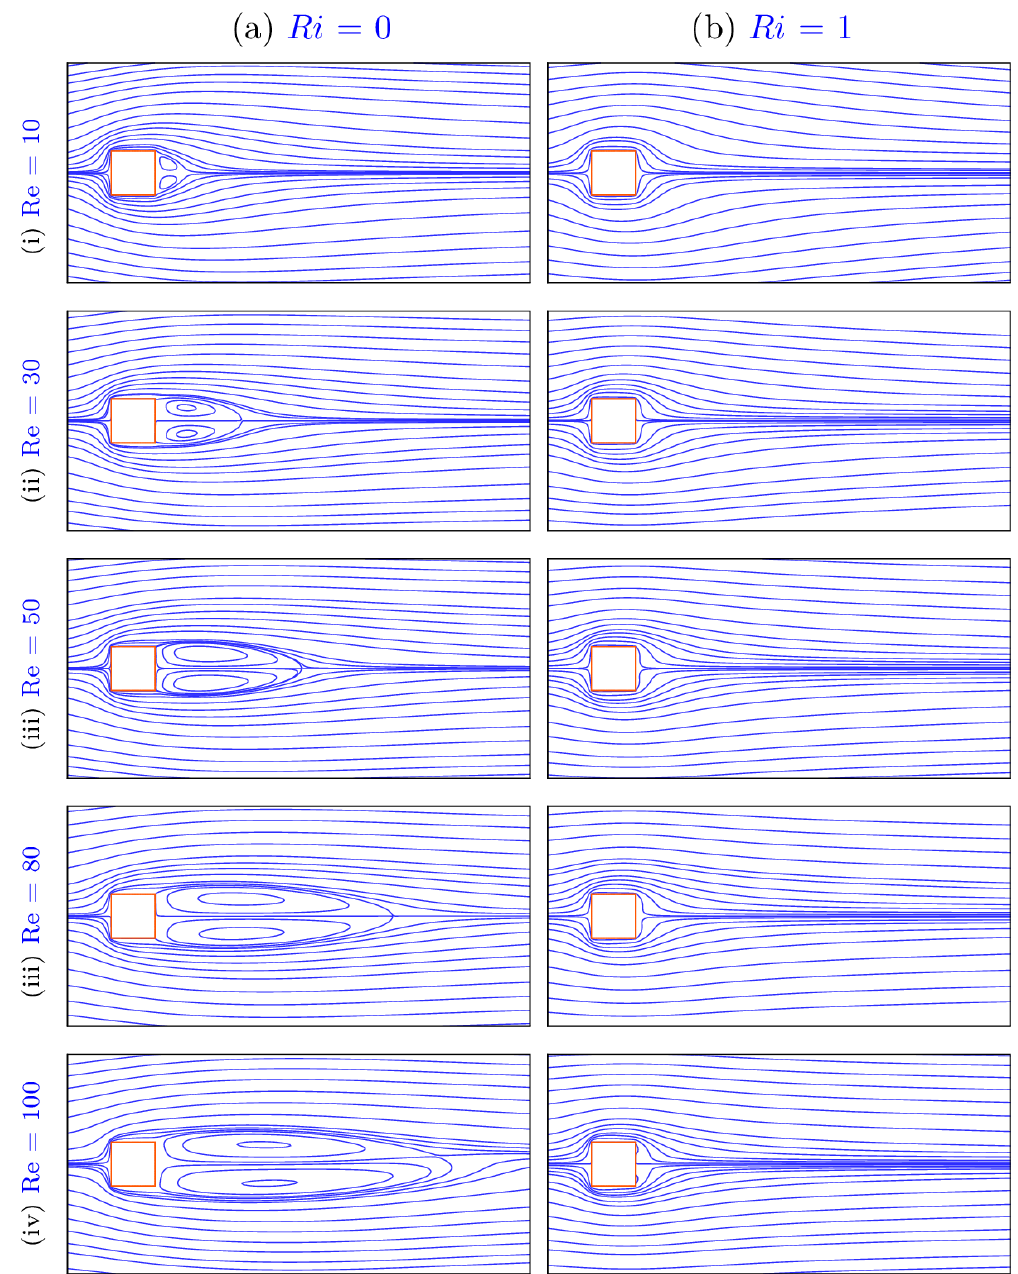
Figure 3. Time-averaged streamlines for different values of Re at φ = 5% for ( a ) Ri = 0 and ( b ) Ri = 1.